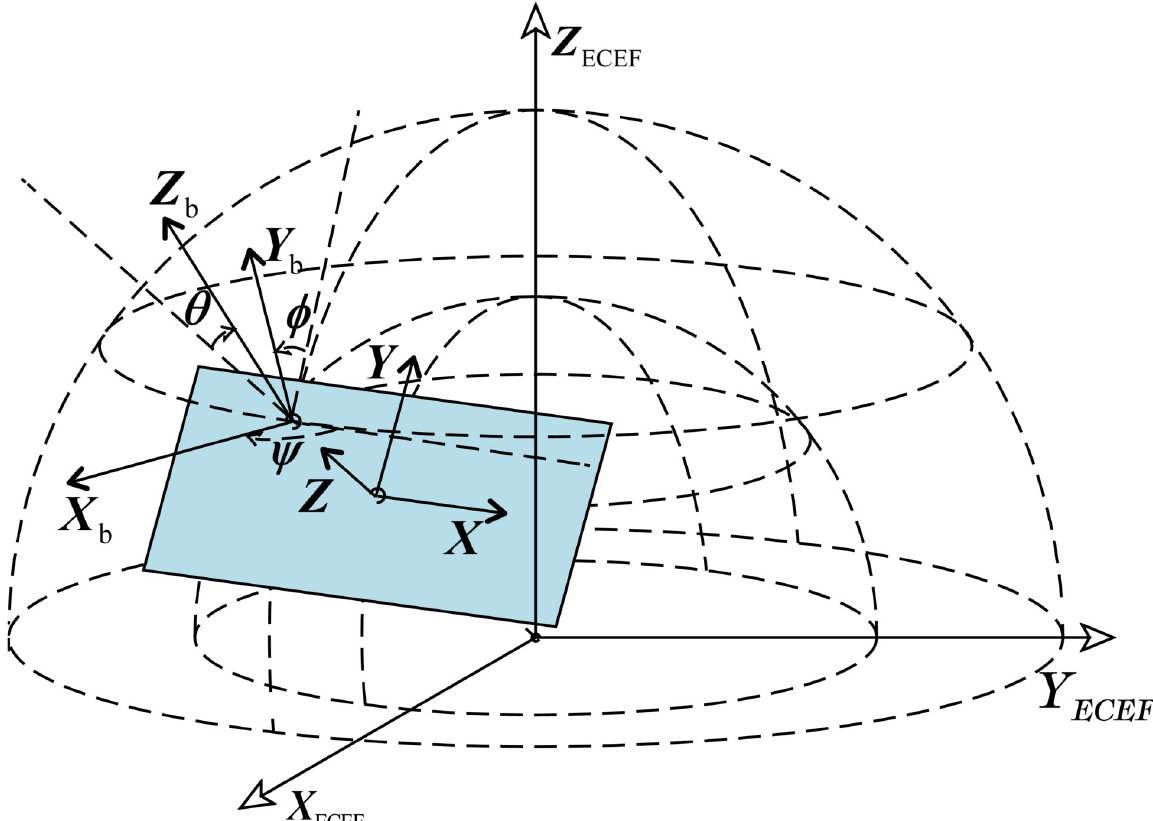
Fig 2. The definition of carrier coordinate system and navigation coordinate